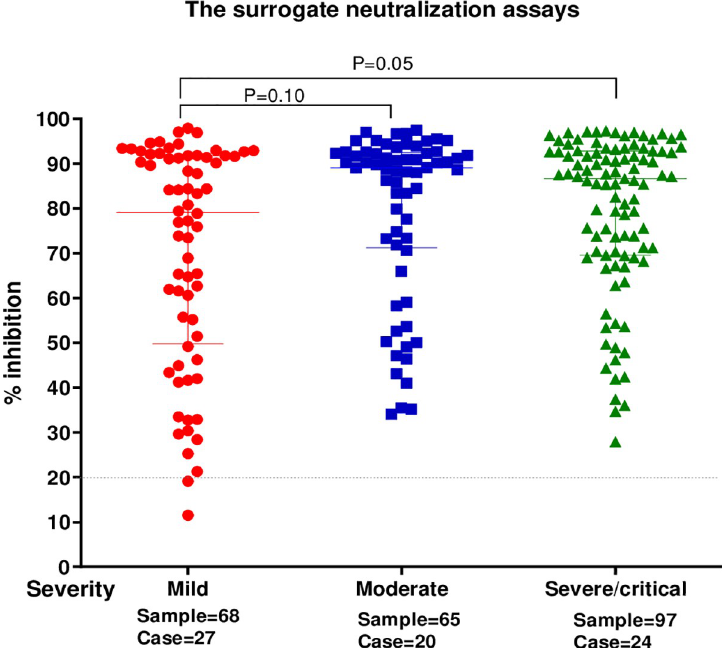
Fig 3. Comparison of sVNT results (%inhibition) between COVID-19 patients with varying degrees of disease severity (mild–asymptomatic or upper respiratory tract infection; moderate–pneumonia without oxygen desaturation, treated with antiviral agents for 5 days or other combined regimens; severe–pneumonia treated with oxygen support and antiviral agents for at least 10 days; critical–pneumonia requiring mechanical ventilation) (lateral axis). Every dot represents one tested specimen and the vertical axis represents the %inhibition of SARS-CoV-2 NAbs tested by sVNT. The dashed line represents the cutoff at 20% inhibition. The horizontal lines indicate the median interquartile range (IQR). The p values were calculated from two-tailed test.